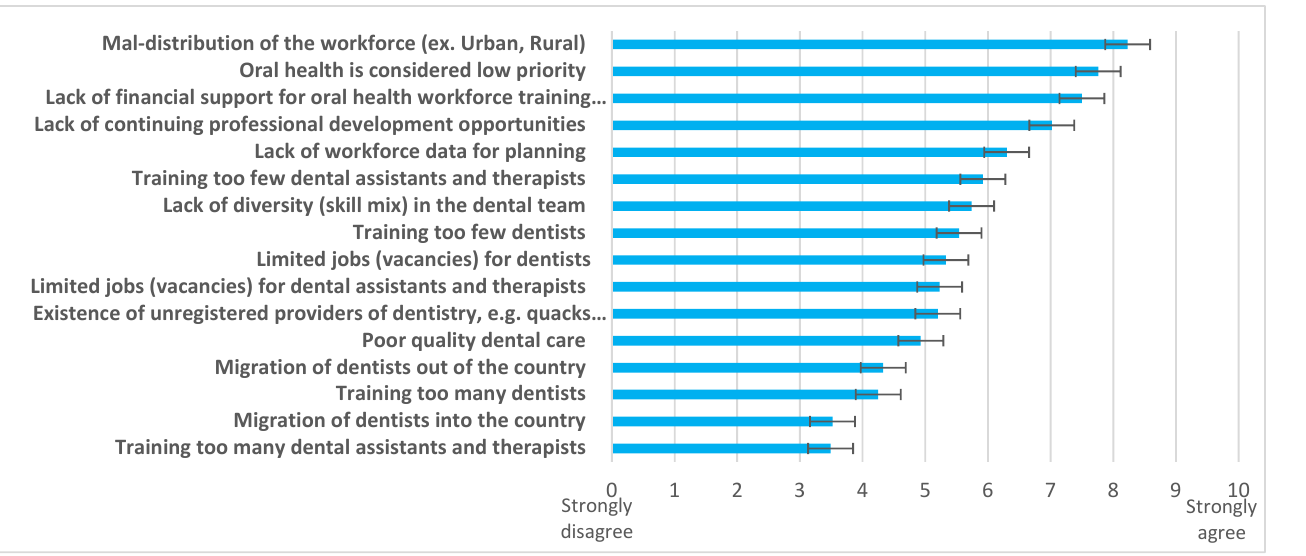
Figure 4. Challenges related to the OHWF highlighted by the AFR, 2019. Source: King’s College London survey, 2019.